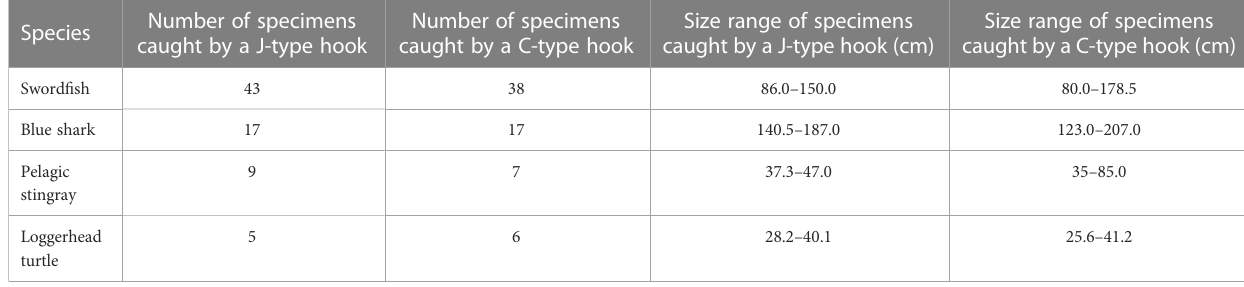
TABLE 2 Number of specimens and size range by species (blue shark, loggerhead turtle, pelagic stingray, and sword fi sh) and hook type (C and J) caught during the fi shing trip (seven fi shing sets).